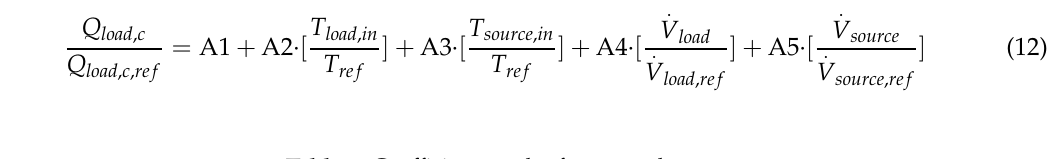
Table 3. Coe ffi cients and reference